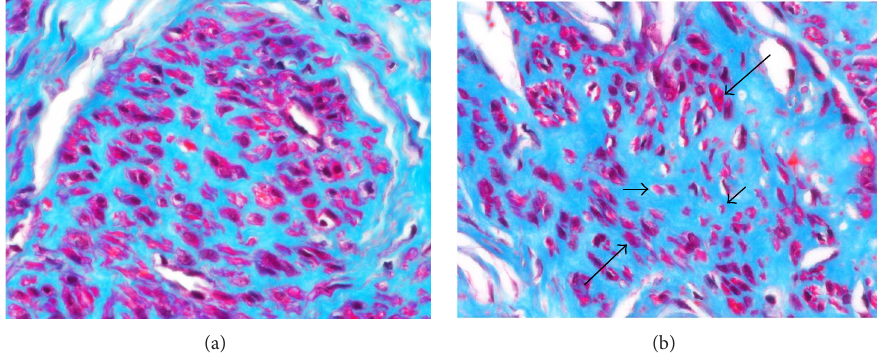
Figure 7: Collagen production by tumor myocytes. (a) In this Masson trichrome stained section, the interstitium of the tumor fascicle is expanded by abundant blue collagen that separates the red staining fibroid myocytes. No interspersed fibroblasts are noted in the blue collagenous stroma, indicating that the stromal matrix has been produced by the tumor myocytes themselves. (b) Many of the myocytes in the central portion of this Masson trichrome stained section are reduced in size (short arrows) in comparison with those above and below (long arrows). These appear to be atrophic cells, although the possibility of artifactual tangential sectioning cannot be excluded. Original objective magnification of (a) and (b):